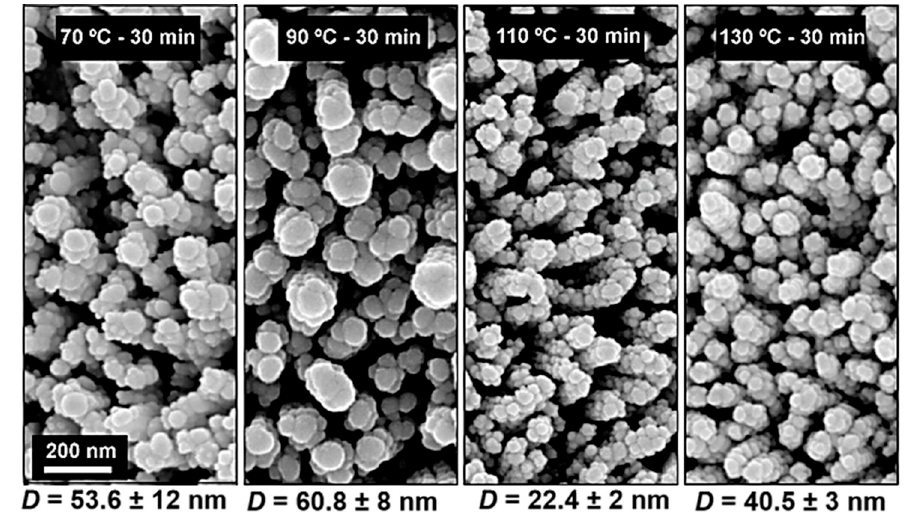
Figure 9. Scanning electron microscopy (SEM) images of ZnO nanorods (NRs) with Ag nanoparticles (NPs) deposited by thermal evaporation. The NRs were produced over 30 min with different synthesis temperatures (70, 90, 110 and 130 °C). The values for the average size (in-plane major axis, D ) of the deposited Ag NPs from 6 nm mass thicknesses are indicated.